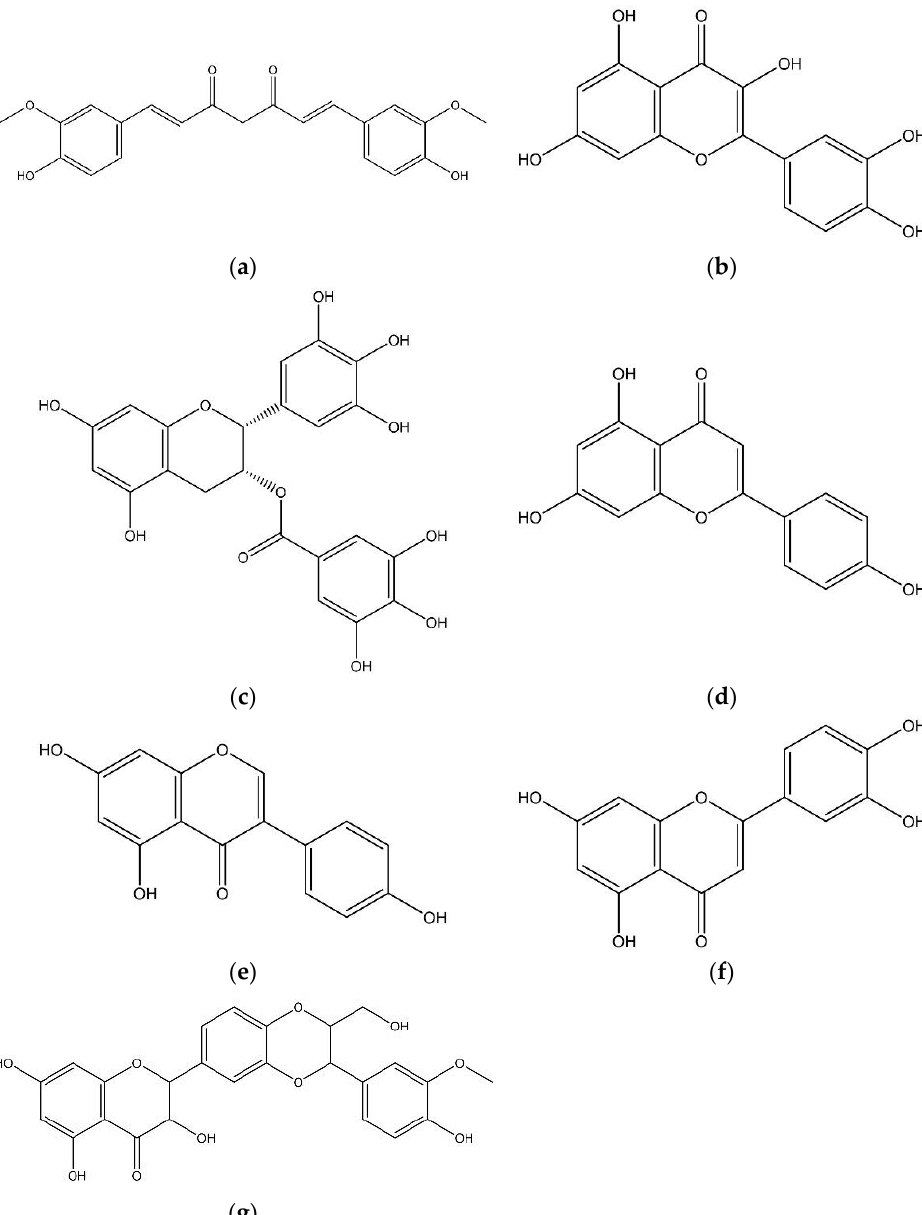
Figure 2. Flavonoid chemical structure. ( a ) Curcumin; ( b ) quercetin; ( c ) epigallocatechin-3-gallate (EGCG); ( d ) apigenin; ( e ) genistein; ( f ) luteolin; ( g ) silymarin.